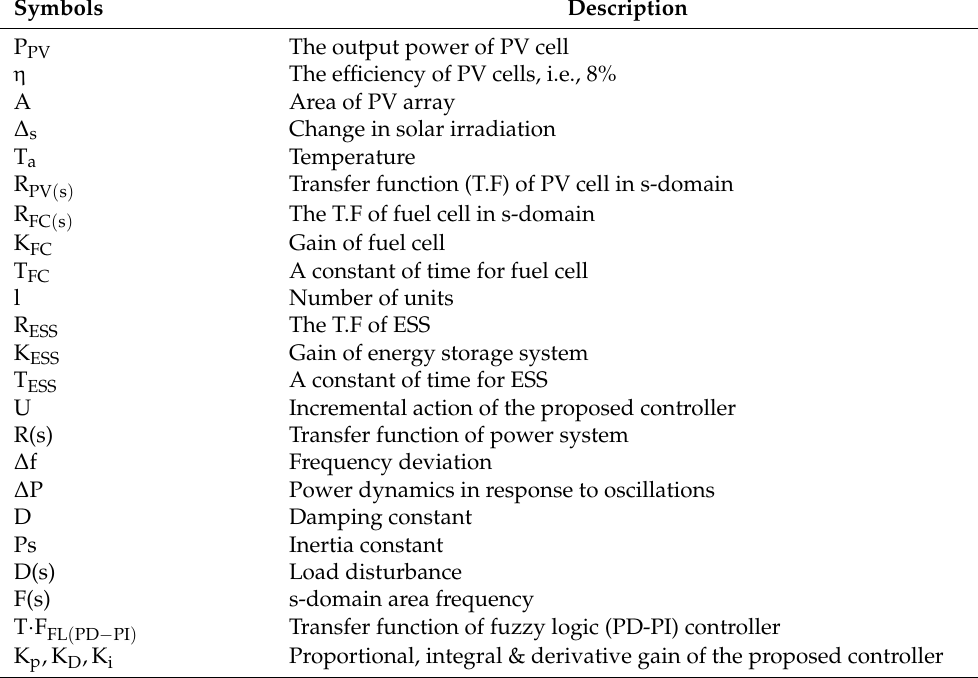
Proportional, integral & derivative gain of the proposed